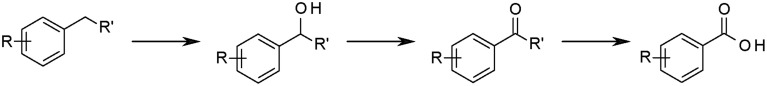
Anaerobic hydroxylation of aromatic hydrocarbons and further transformations. R = H, alkyl; R′ = H, methyl, ethyl, propyl.